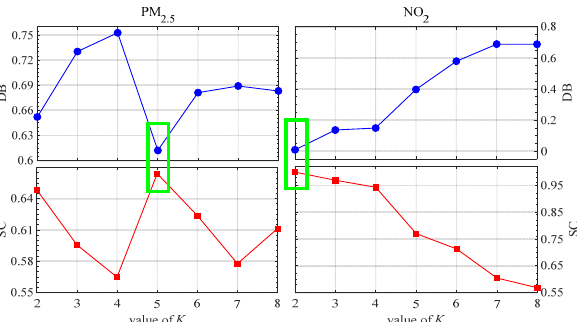
Figure 7. Evaluation of spectral clustering algorithm of PM 2.5 and NO 2 with respect to the value of K. Two criteria are used, namely, the Davies ‐ Bouldin index (DB) and silhouette coefficient (SC). The criterion values in the green rectangle refer to the optimal K.